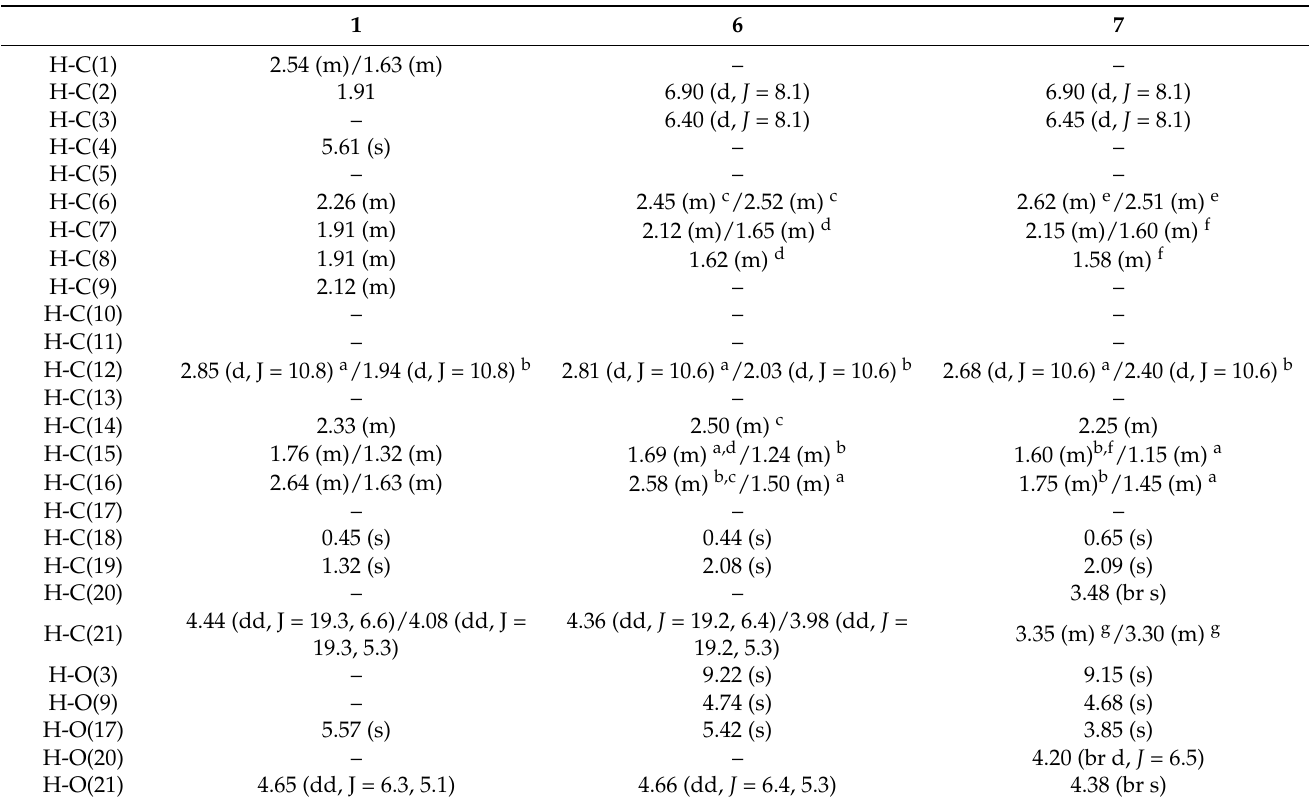
Table 4. 1 H-NMR data of compounds 1 , 6 , and 7 at 400 MHz in DMSO- d 6, δ in ppm, and J in Hz.